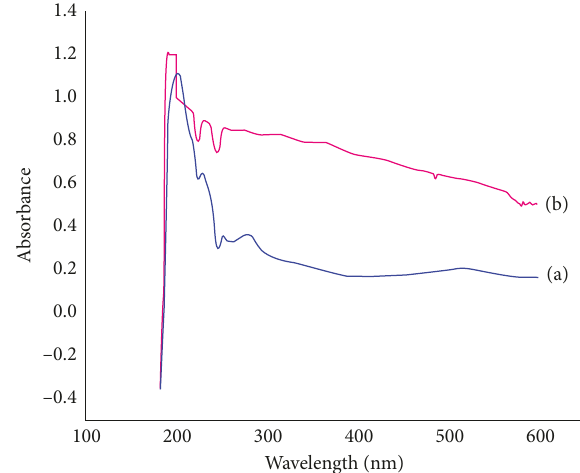
Figure 2: UV-Vis spectra of (a) the mortiño berry extract and (b) as-prepared multicomponent